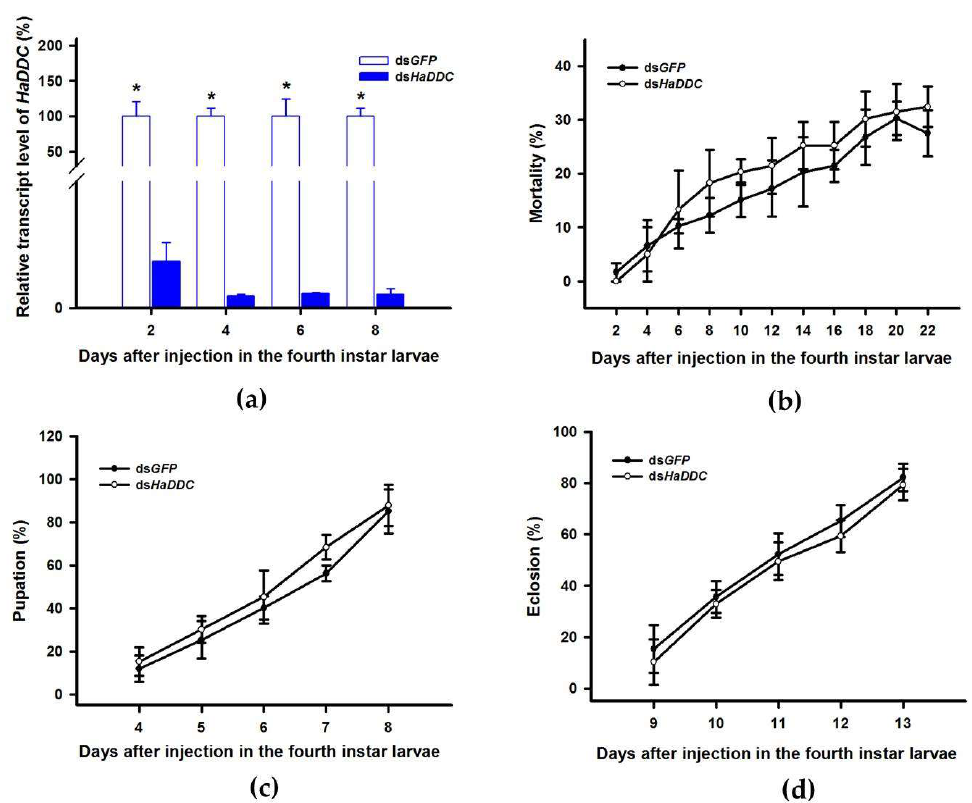
Figure 5. Time-dependent suppression of HaDDC transcript in fourth instar larvae of H. axyridis injected with ds HaDDC at 300 ng / larva or ds GFP at 300 ng / larva as determined by RT-qPCR ( a ), time-dependent mortality ( b ), pupation rate ( c ), and eclosion rate ( d ) in ds HaTH and ds GFP -injected larvae. The relative transcription levels (%) are presented as the mean and SE of three replicates with three insects. There were three replicates in the determination of mortality, pupation rate, and emergence rate, each of which had at least 30 fourth instar larvae. Notability analysis was based on SPSS (v. 22, IBM Corp. Armonk, NY, USA) followed by One-Way ANOVA ( p < 0.05) within the same time point. “*” indicates a significant di ff erence in relative transcript level of HaDDC between insect injected with ds HaDDC and ds GFP